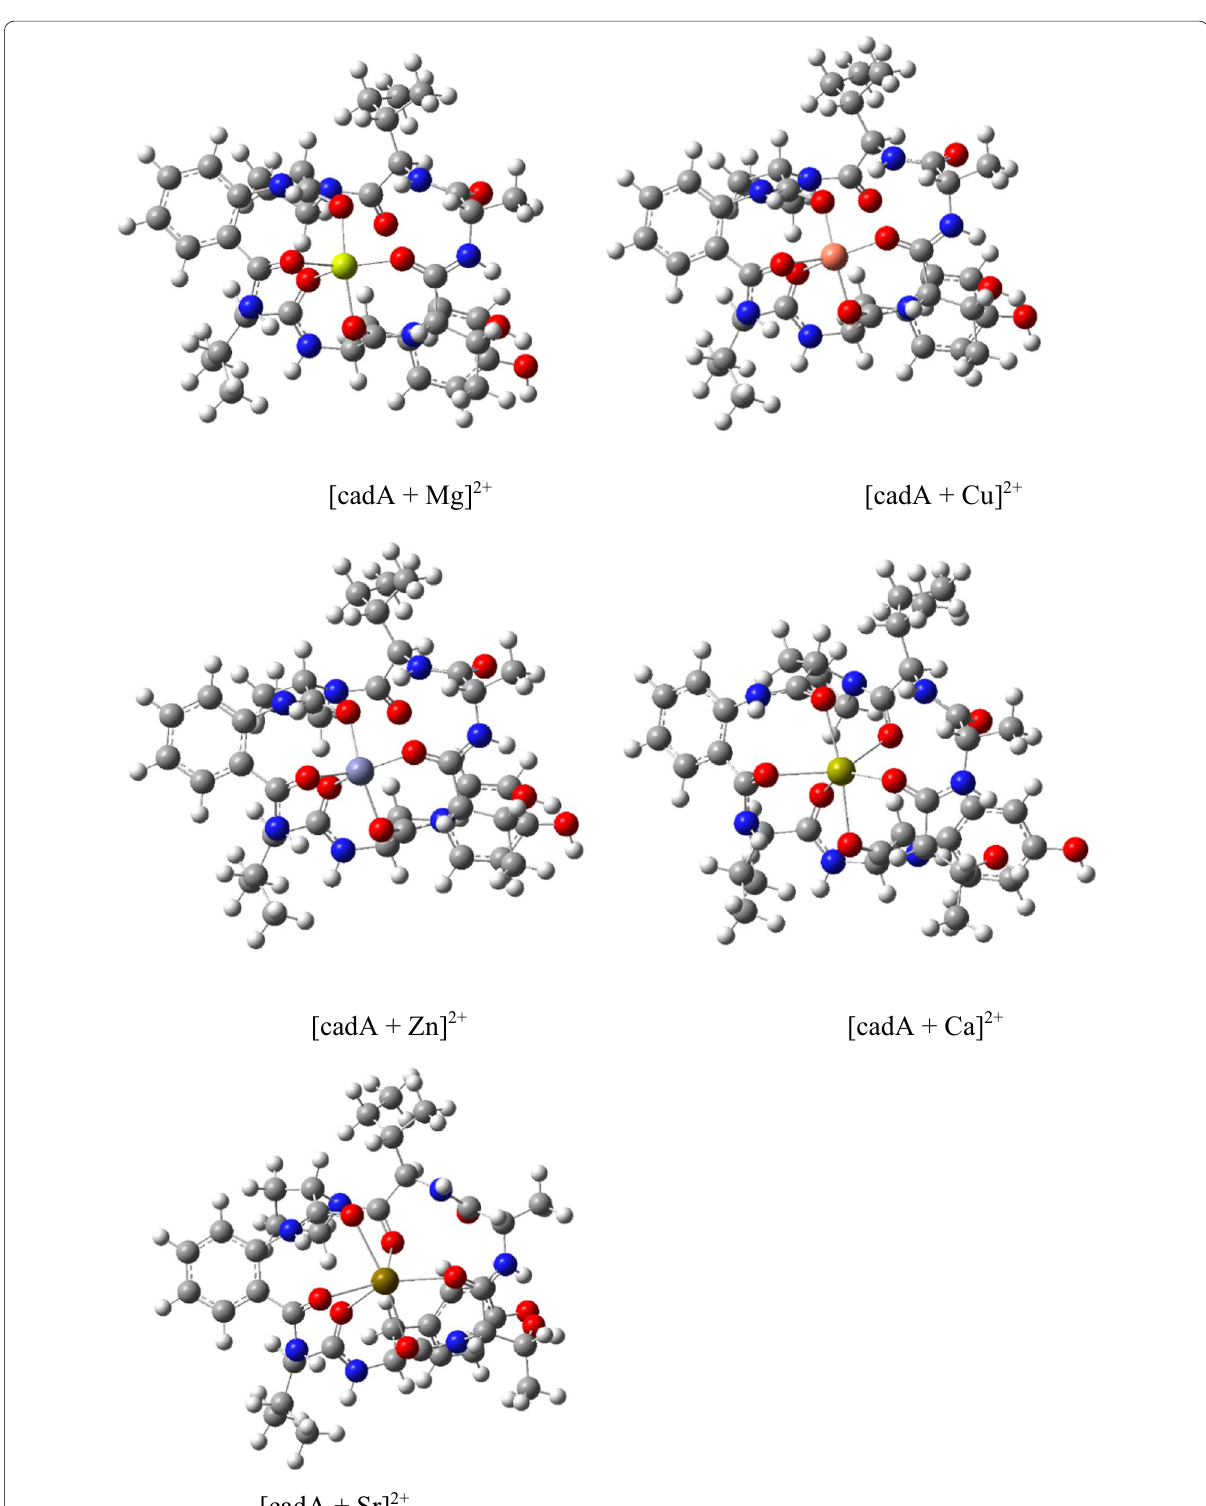
Fig. 3 Optimised structures of cadA–Me complexes calculated at the B3LYP level of theory, Me